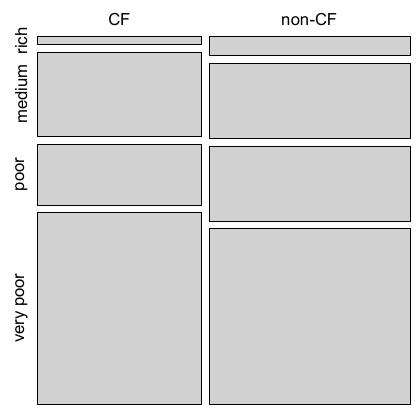
Figure 2. Wealth distribution of CF member vs. non-member households ( n = 100).